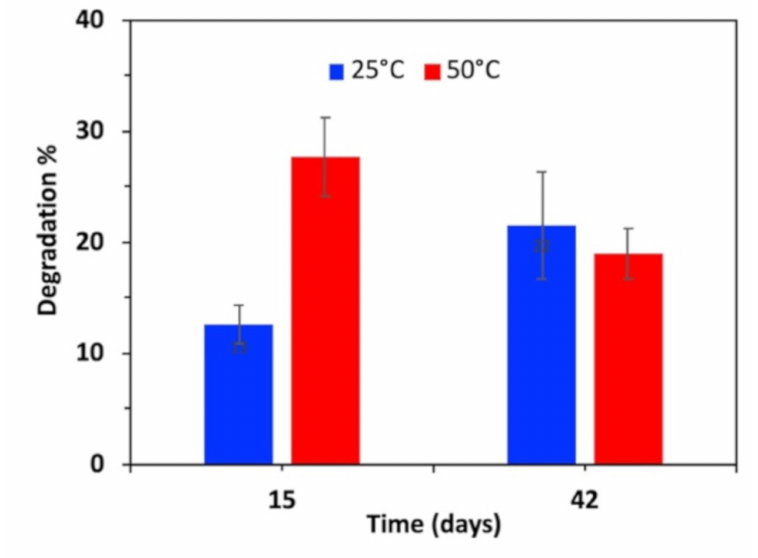
Figure 6. Temperature dependence of M-GLY degradation at pH